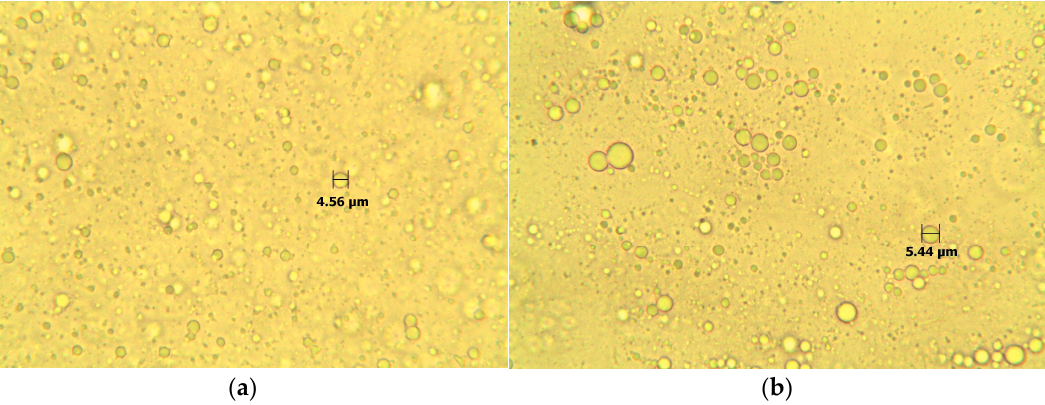
Figure 1. Microscopic gel structure: ( a ) Carbopol gel after adding the reference microemulsion (400 × magnification); ( b ) Xanthan gel after the adding of the reference microemulsion, (400 × magnification).